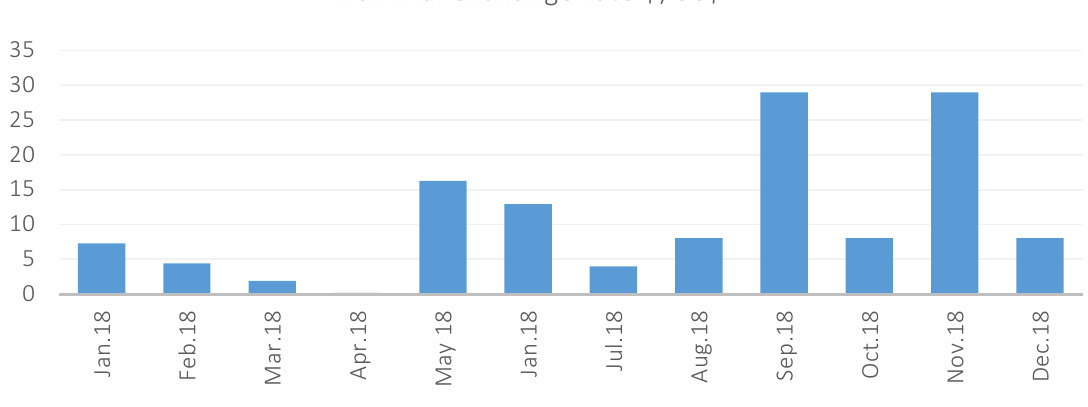
Figure 4. USA/ARS nominal exchange rates in